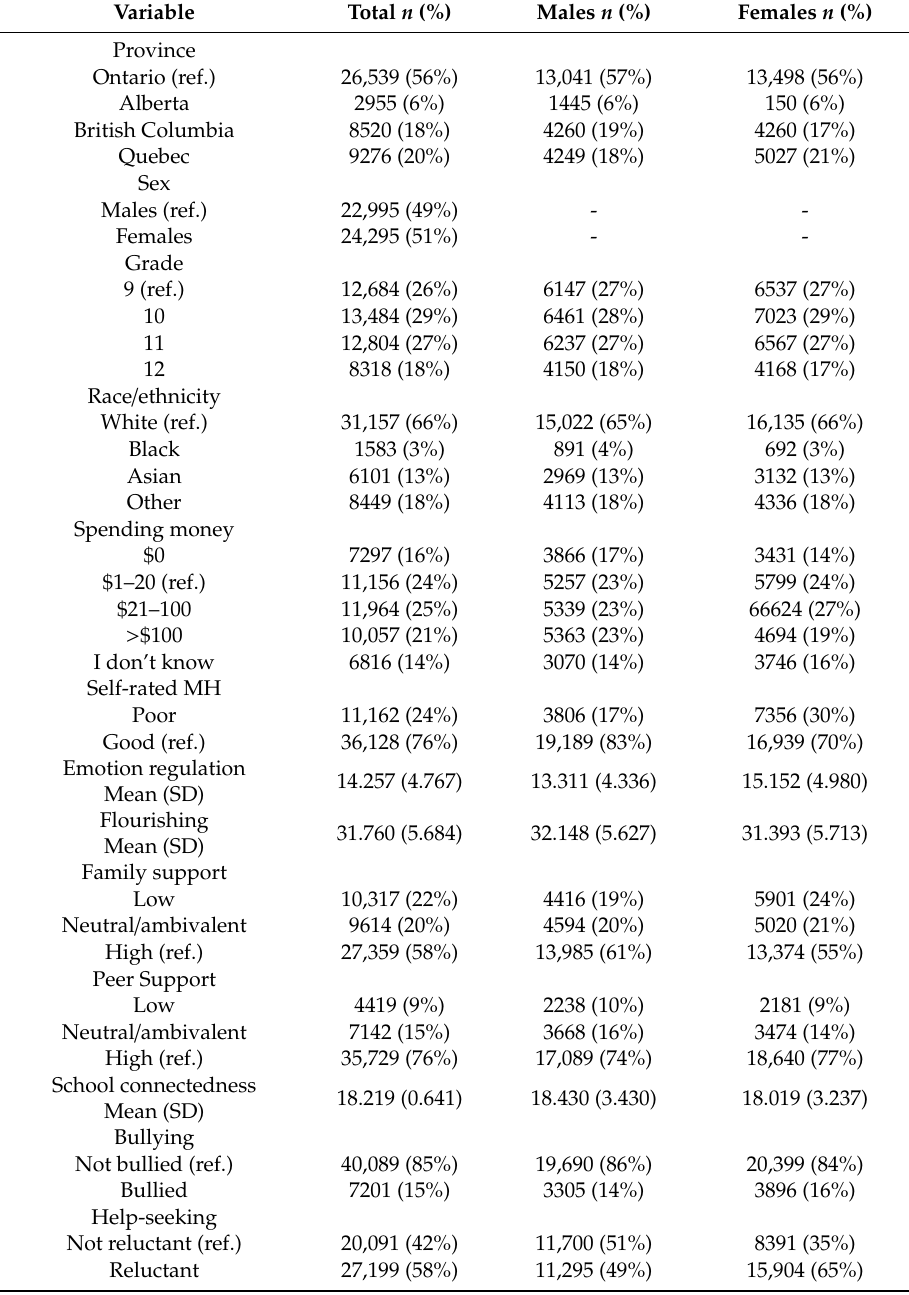
Table 1. Demographic and psychosocial characteristics of students participating in Year 6 and 7 (2017–2018, 2018–2019) of the COMPASS Study in Canada ( n =